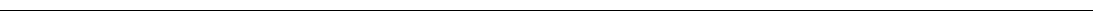
indicate mean fl uorescence intensity (MFI), whereas results from different experiments are summarized in bottom graph. Cells were gated as in Supplementary Fig. 11b. b ELISA of serum total and PCh-reactive IgM and IgG3 from WT and TNFSF13 -Tg mice before (d0) and after (d7) daily i.p. treatment with rapamycin. c ELISA of serum TNP-speci fi c IgM and IgG3 (d7) from WT and TNFSF13 -Tg mice following i.p. immunization with TNP-Ficoll supplemented with daily i.p. injection of control vehicle or rapamycin. d ELISA of serum TNP-speci fi c or total IgM and IgG3 (d7) from Mtor + / + Cd21 cre/ + or Mtor fl / fl Cd21 cre/ + mice following i.p. immunization with TNP-Ficoll. e RT-PCRs of mRNAs for AID ( Aicda ), I µ -C µ , I γ 3-C γ 3, and GAPDH ( Gapdh ) in splenic resting B cells from Mtor fl / fl Cd21 cre/ + or Mtor + / + Cd21 cre/ + mice treated for 3 days with APRIL in the presence or absence of LPS. Results are normalized to mRNA for Gapdh and quanti fi ed as relative expression (RE) compared to B cells from control Mtor + / + Cd21 cre/ + mice. f ELISA of total IgG3 secreted